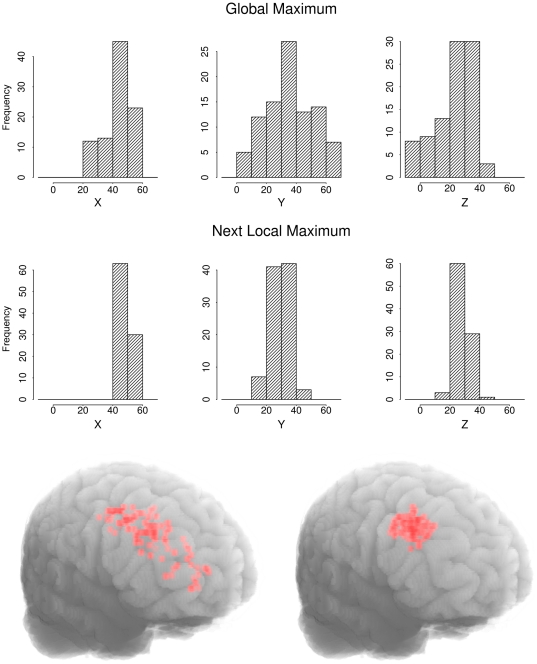
Seed Voxel Localization.Top: Frequencies of MNI-coordinates in the X, Y, and Z dimension for right DLPFC seed regions identified with the global maximum and the next local maximum starting at 52, 30, 30. Bottom: Individual seed-region localization in the right DLPFC for the functional connectivity analyses based on the global maximum (left) and the next local maximum approach (right).